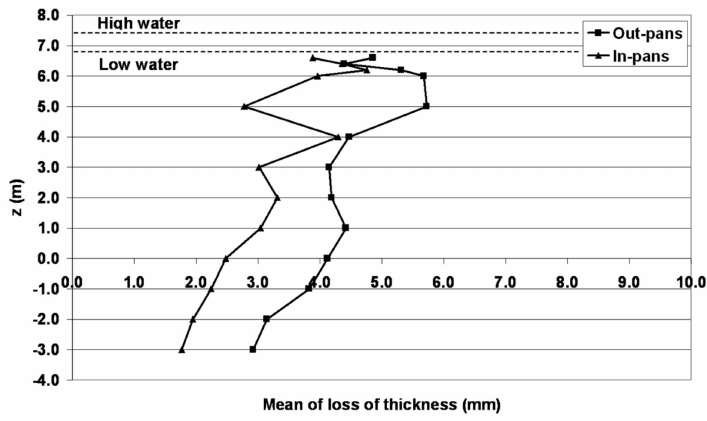
Figure 8. Mean of loss of thickness on in- and out-pans of sheet piling according to z—HA7d.